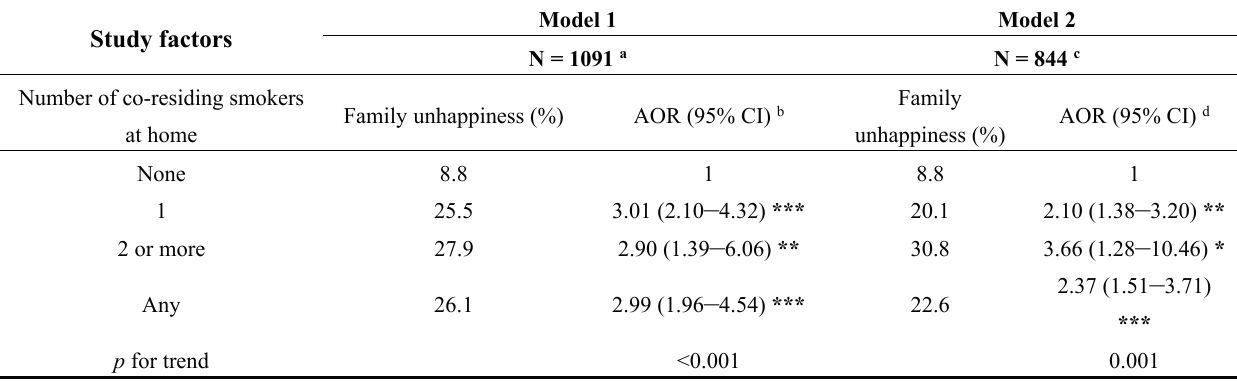
Table 3. Adjusted odds ratio (AOR) of family unhappiness by family smoking and SHS exposure at home in primary students in Hong